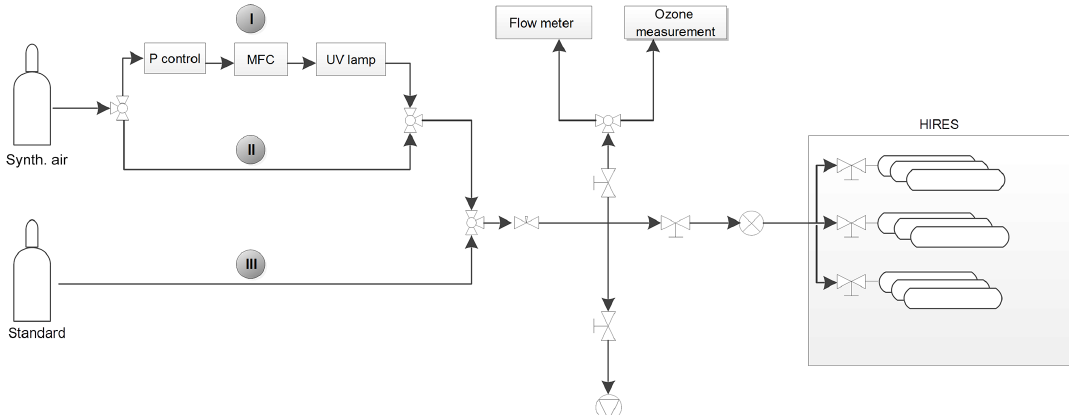
Figure 2. Schematic view of the gas flows for filling HIRES canisters for the storage experiments. Samples can be pressurized with either pure air from a standard gas bottle (flow path III), pure synthetic air (path II), or with a mixture of both. Alternatively, the flow of synthetic air can be directed to pass an ozone-generating UV lamp (path